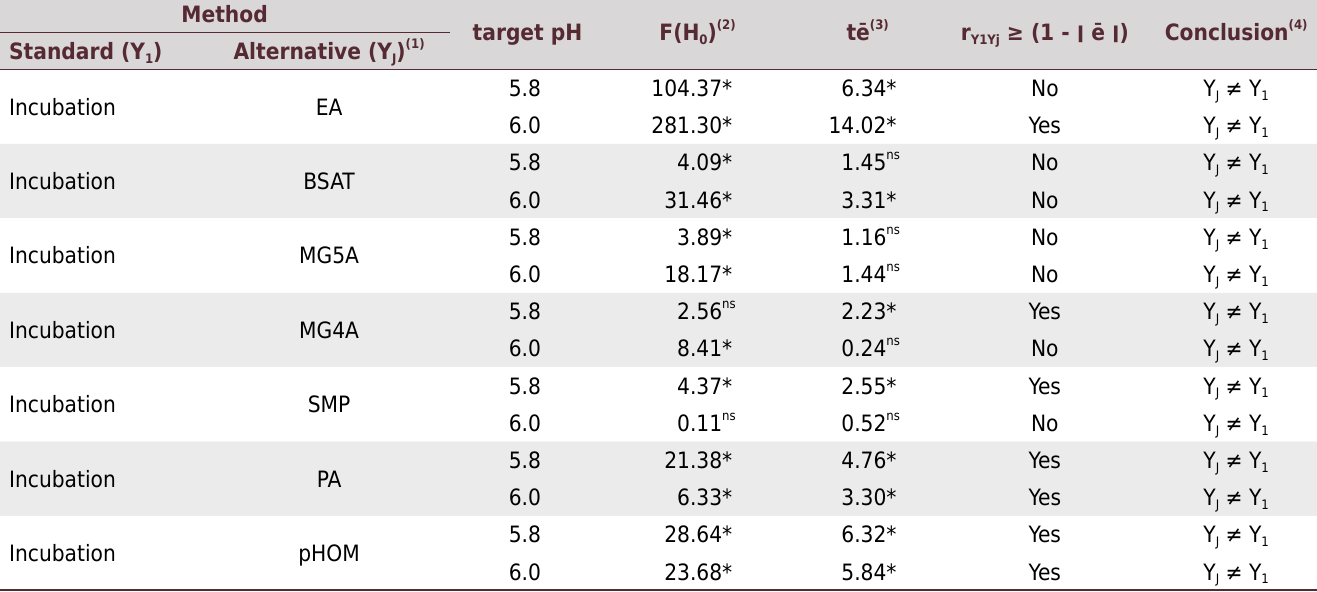
Table 5. Summary of the statistical procedure to test the identity between lime requirement (LR) determined from the standard incubation method to raise soil pH to target values of 5.8 and 6.0, and LR determined from the alternative traditional